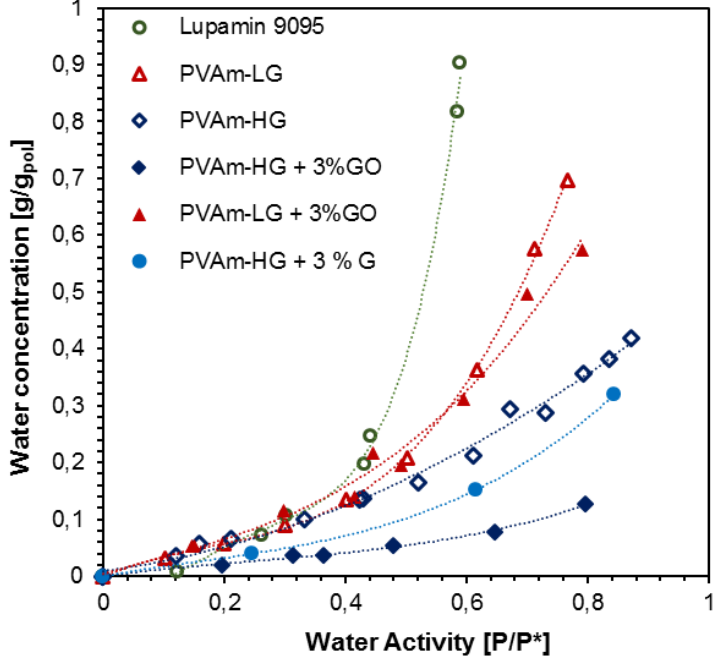
Figure 9. Water sorption isotherms at 35 °C for PVAm at different degrees of purification and with different types of filler. Lupamin 9095 sorption data from [40].